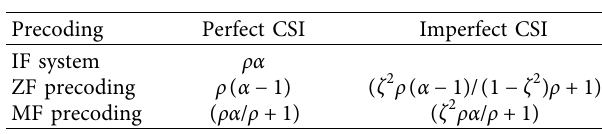
Table 3: SNR/SINR expressions of basic precoding techniques under massive